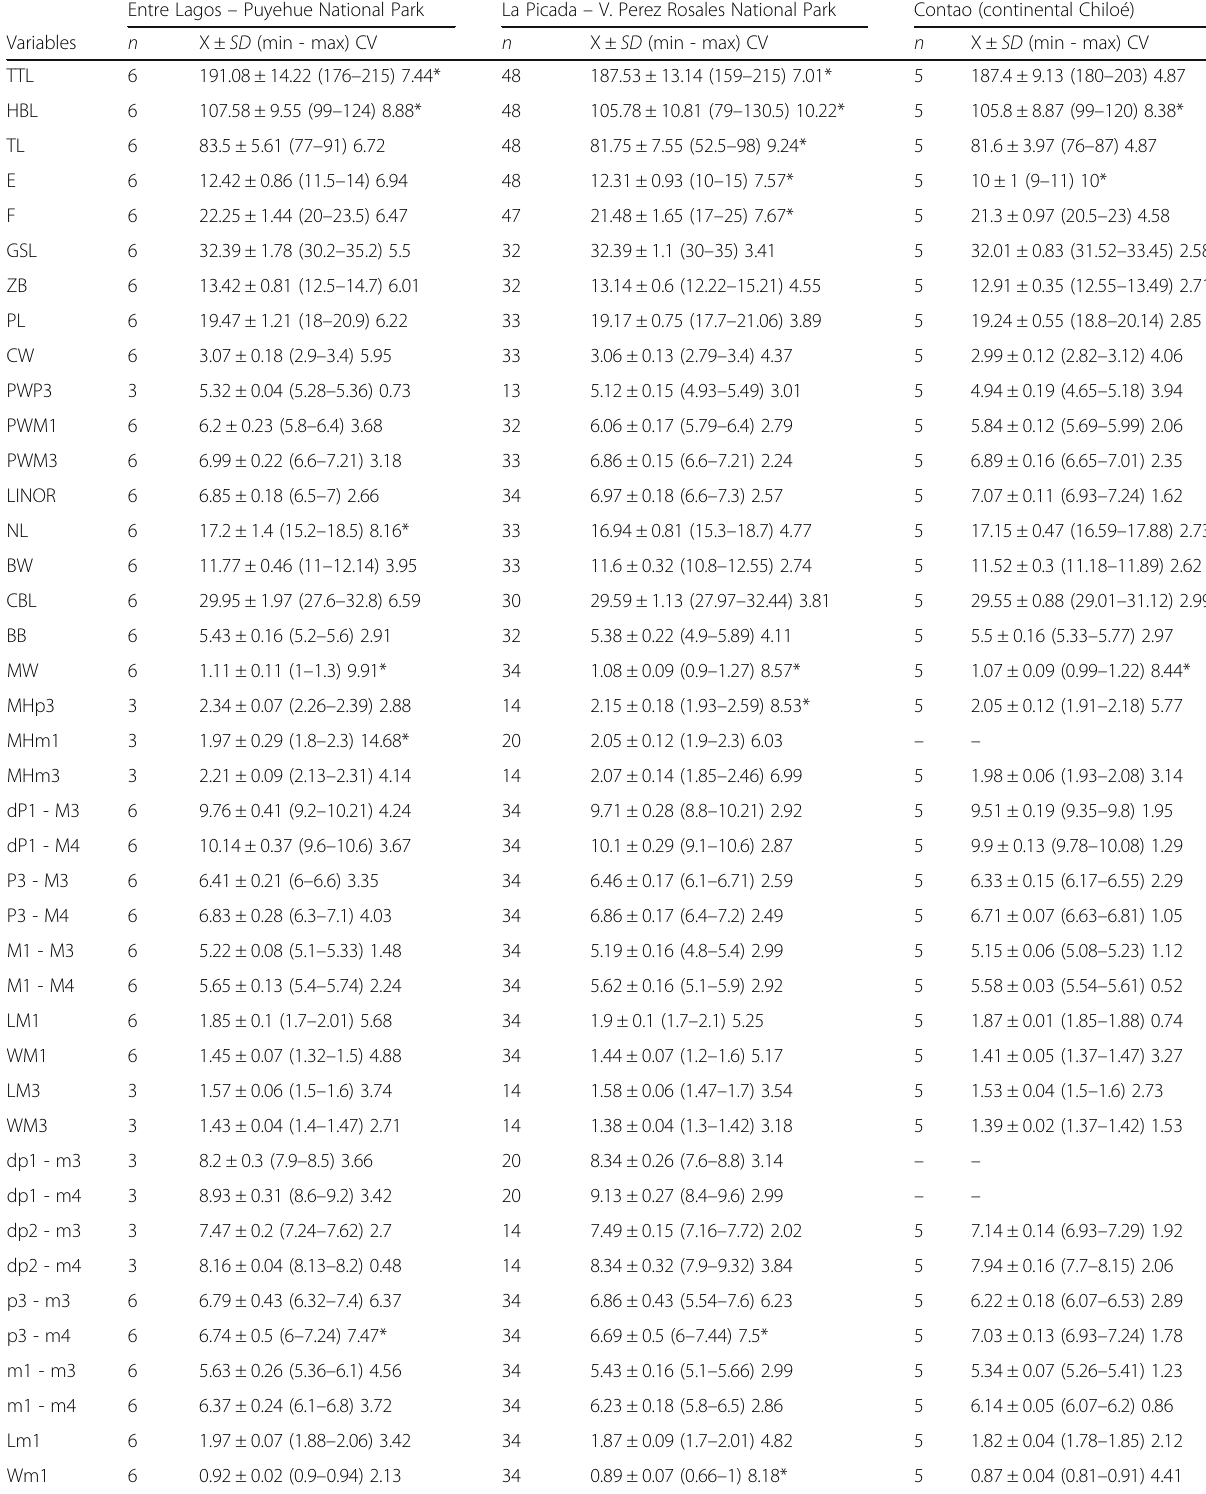
Table 1 External and craniodental measurements of Rhyncholestes raphanurus Osgood, for pooled samples from continental Chile. Total number of specimens ( n ), mean (X), SD , minimum and maximum of each variable, and coefficient of variation are presented for each locality. Asterisks mark Coefficient of Variation (CV) values higher than seven, following Bedeian and Mossholder